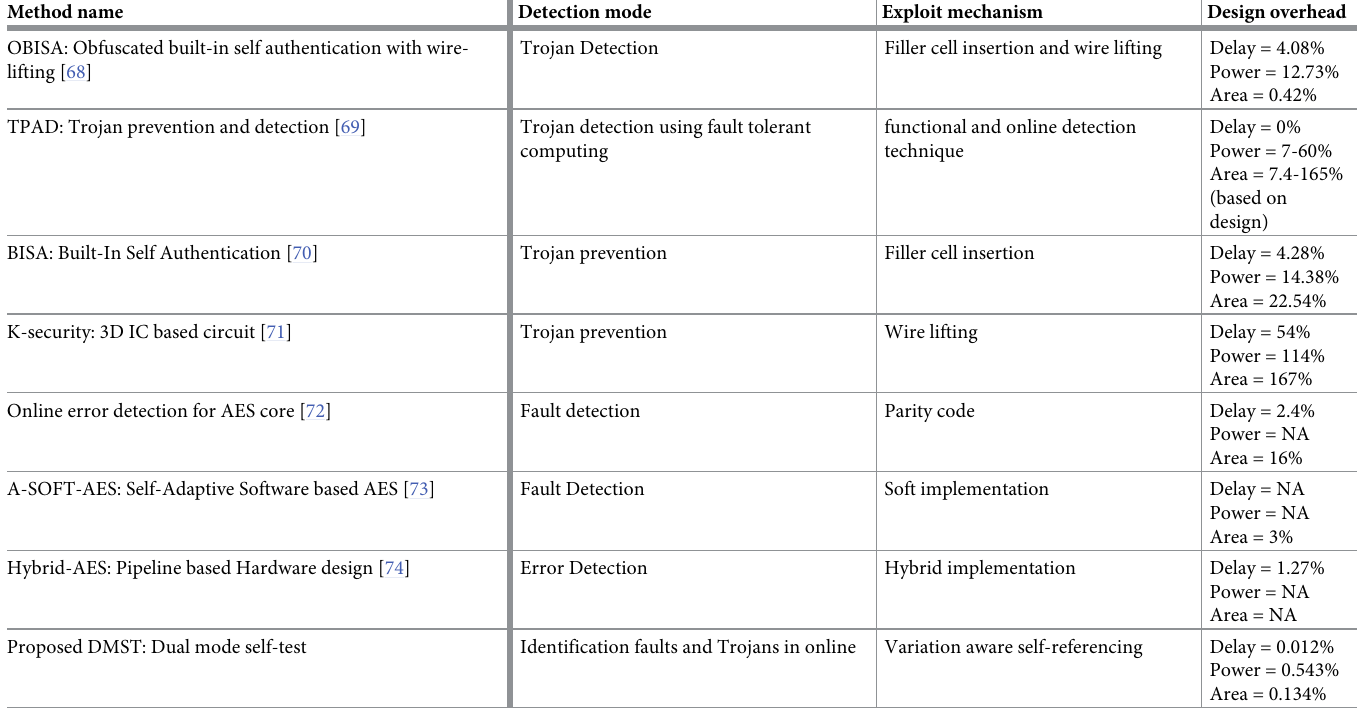
Table 4. Comparison with the state of the art fault and Trojan detection of AES in dual mode self-test implementation. Method